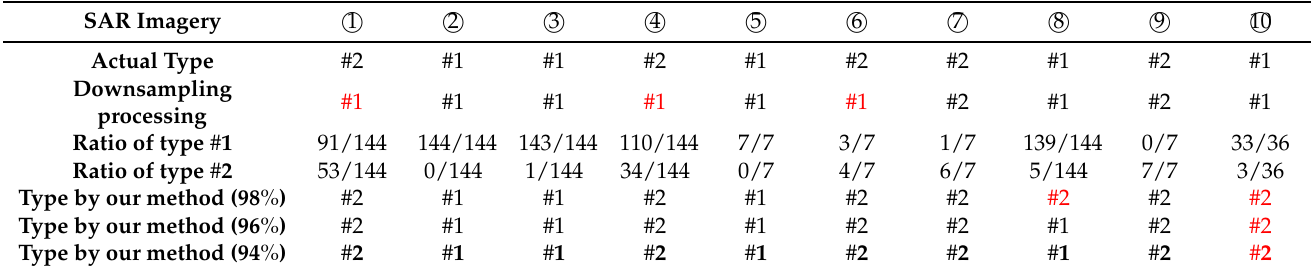
Table 2. Classification results of ten large imageries based on VGGNet13. The wrong classification are marked in red. SAR Imagery